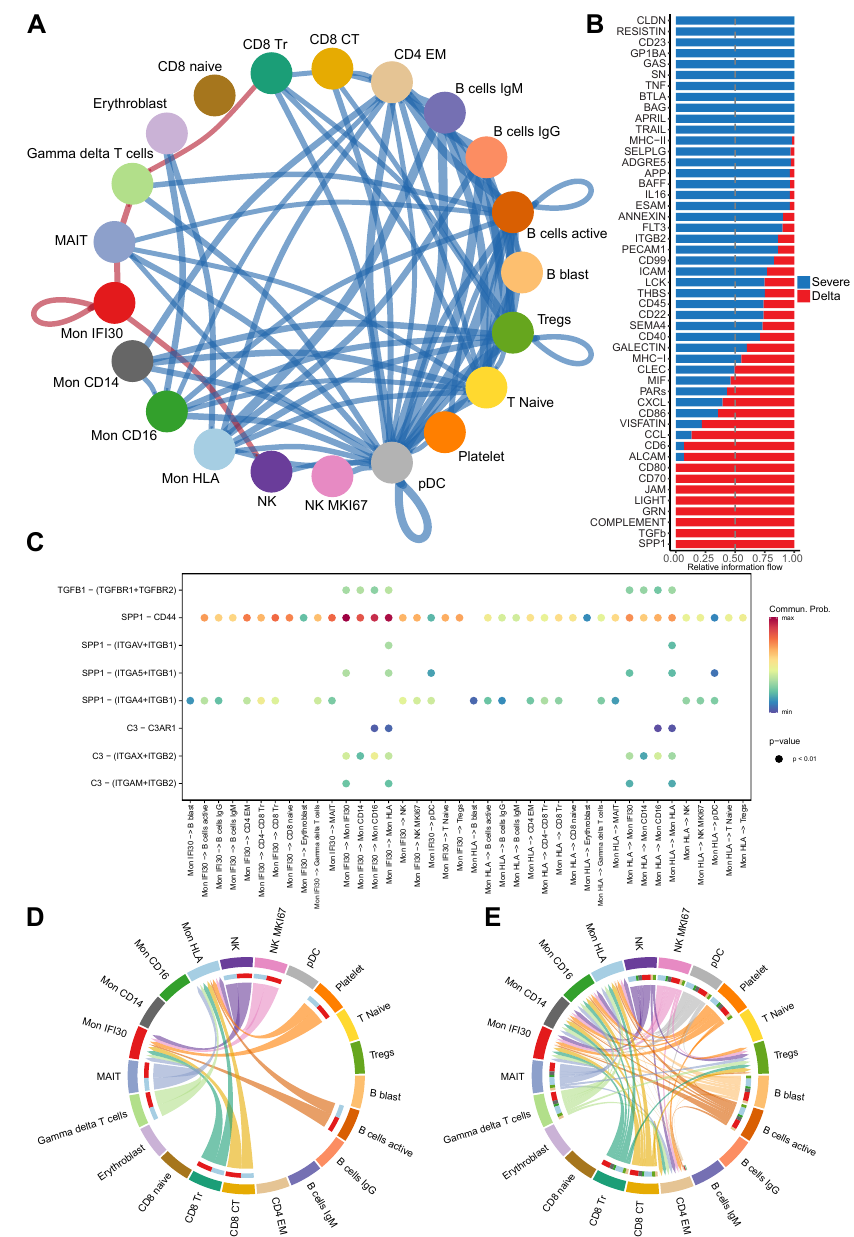
Figure 5. ( A ) Circle plot showing predicted differential cell–cell communications between severe Delta and Wuhan-like groups (red for gained, and blue for lost in Delta cases). We identified several newly gained communications for the Delta cohort established by Mon IFI30 with MAIT and NK cells and by gdT-cells with MAIT and CD8 Tr cells. ( B ) Bar plot showing the intensity of context-specific signaling pathways measured as relative information flow as implemented in CellChat. TGF beta and SPP1 are predicted as main signaling molecules involved in cell–cell communication for severe Delta COVID-19 aside from Resistin, CD23, and Caledon. ( C ) Dot plot showing cell pairs (x-axis) and predicted interacting ligand–receptors (y-axis) for SPP1, TGF beta, and complement pathways. Color on the dot plot shows the strength of a given ligand–receptor interaction quantitatively represented by a probability value obtained with CellChat and calculated based on the law of mass action relying on the average expression of the ligand in a cell group and receptor by another cell group. ( D ) Chord diagram showing interacting cell types in severe samples via CCL-CXCL axis for severe Wuhan-like samples. ( E ) Chord diagram showing interacting cell types via CCL-CXCL axis for severe Delta